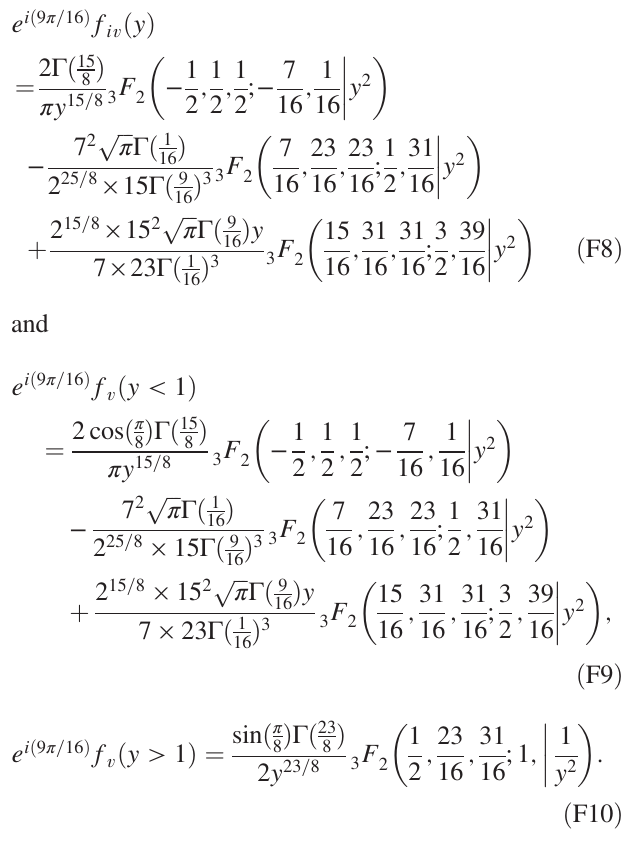
Figure 11(b) from the main text plots the magnitude of the scaling functions f